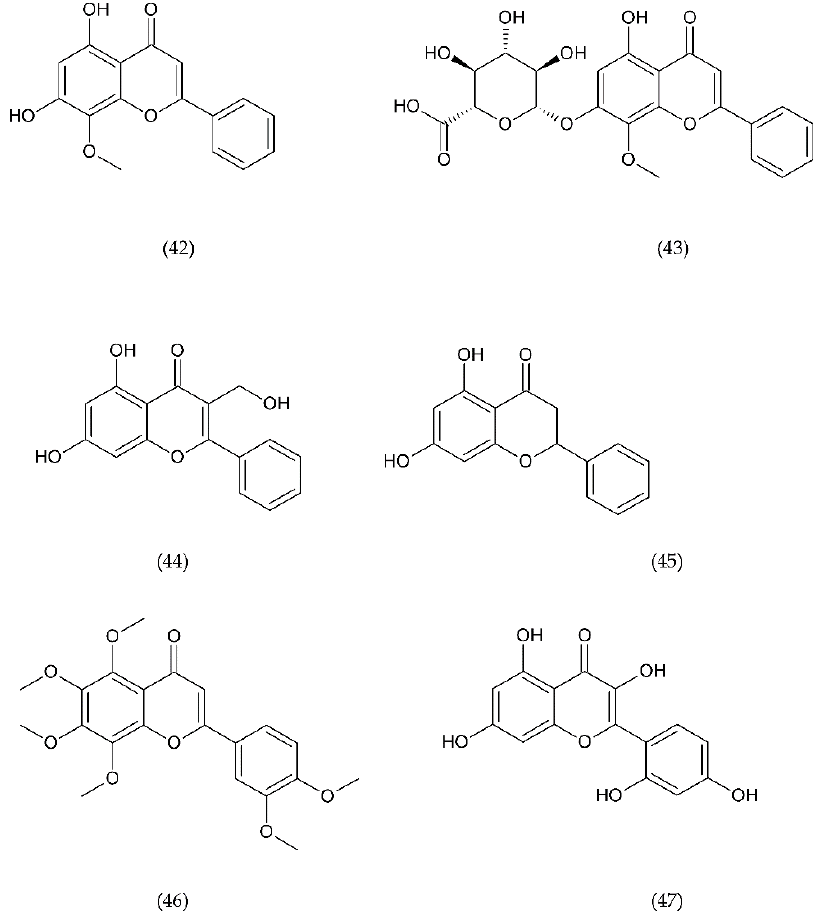
Figure 15. Chemical structures of flavonoids: wogonine (42) wogonoside (43), galangin (44), pinocembrin (45), nobiletin (46), and morin (47).